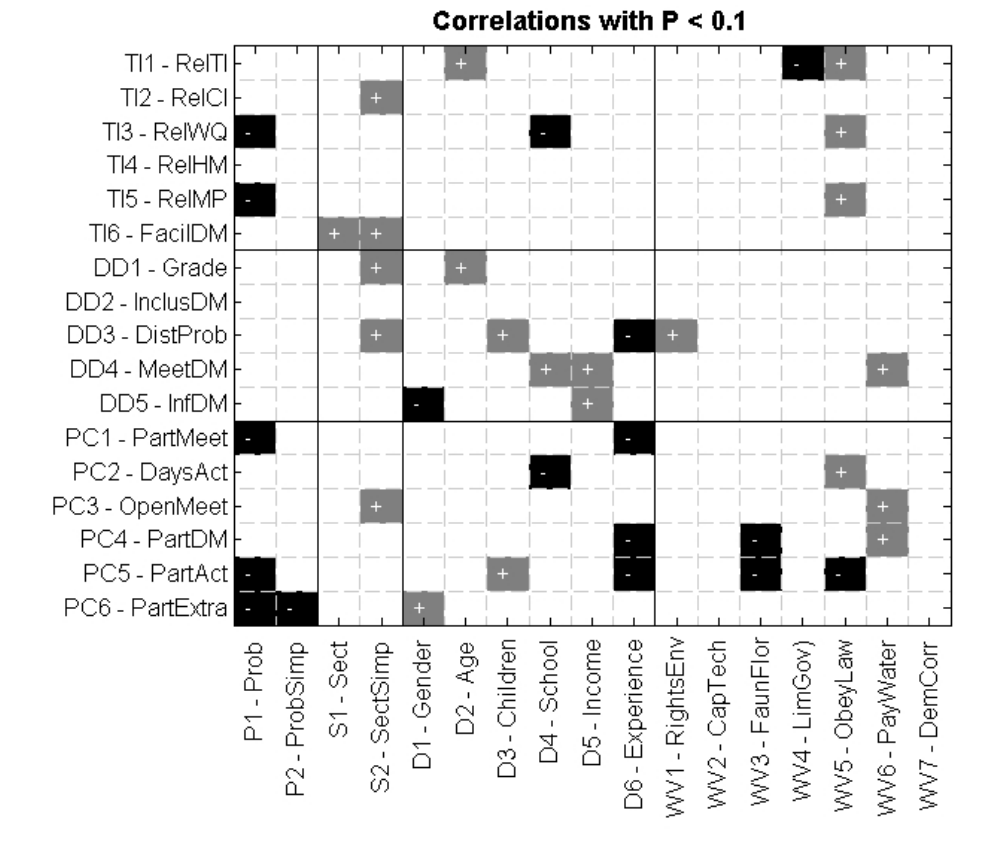
Fig. 2. Table of correlations among independent variables – diversity in observable and unobservable attributes of identity at the level of basin council – and dependent variables – outcomes at the level of basin council. Positive correlations significant at a = 0.1 are shown as grey squares with a ‘+’ sign; negative correlations significant at a = 0.1 are shown as black squares with a ‘-’ sign; white indicates a lack of significant correlation at a = 0.1. Solid black lines divide groups of independent and dependent variable proxies. For example, WV 3 (5th column from right) has two significant negative correlations with proxies of participation (PC4 and PC 5). Please see Appendix 1 for a complete list of questions and the means by which they were